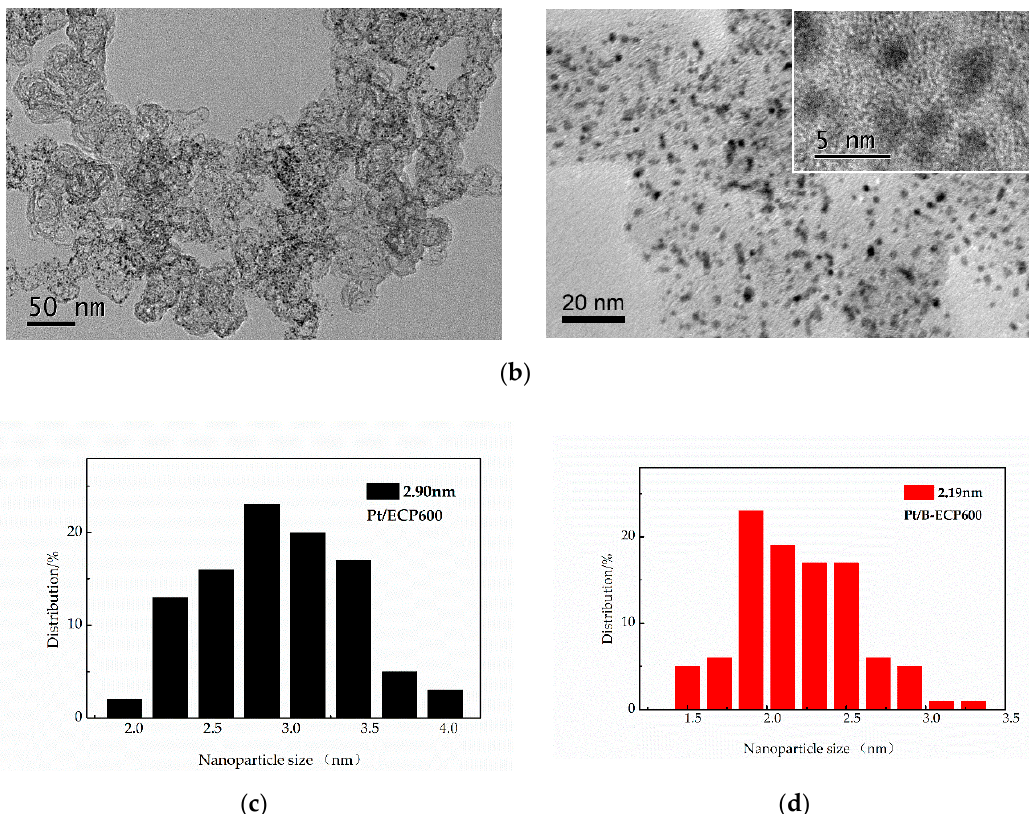
Figure 3. TEM images for ( a ) Pt/ECP600 and ( b ) Pt/B-ECP600; and particle size distributions for ( c ) Pt/ECP600 and (d) Pt/B-ECP600.